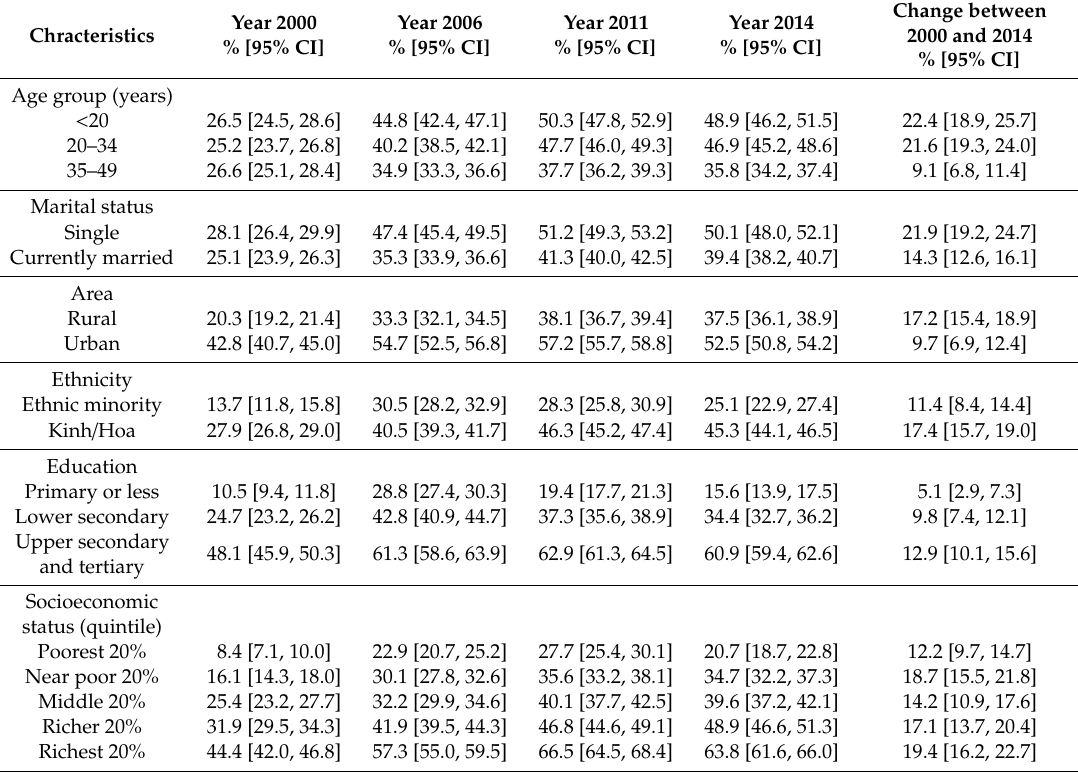
Table 2. Percentage and 95% CI of comprehensive knowledge about HIV among women aged 15–49 years according to various factors (weighted),